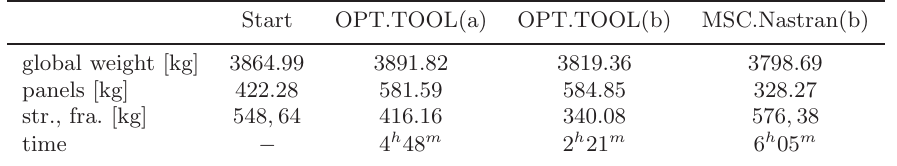
Fig. 8. OPT.TOOL space module analysis. Global (a) and local group weights (b) for the initial FE (dotted line) and the actual (continuous line) models. Table 2. OPT.TOOL analysis (a) vs. MSC.Nastran comparison (b) results on a space